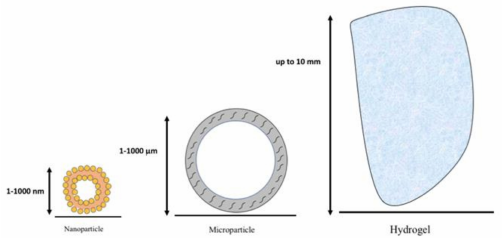
Figure 1. Schematic representation of the sizes of the three main types of drug delivery systems: